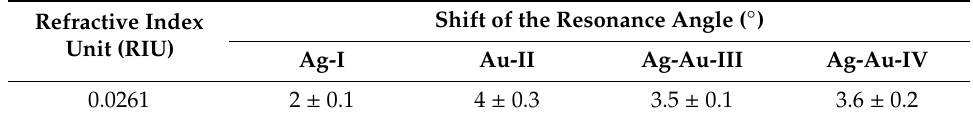
Table 3. Shift in Resonance Angle for the Sensors due to a Refractive Index Change of 0.0261 RIU.